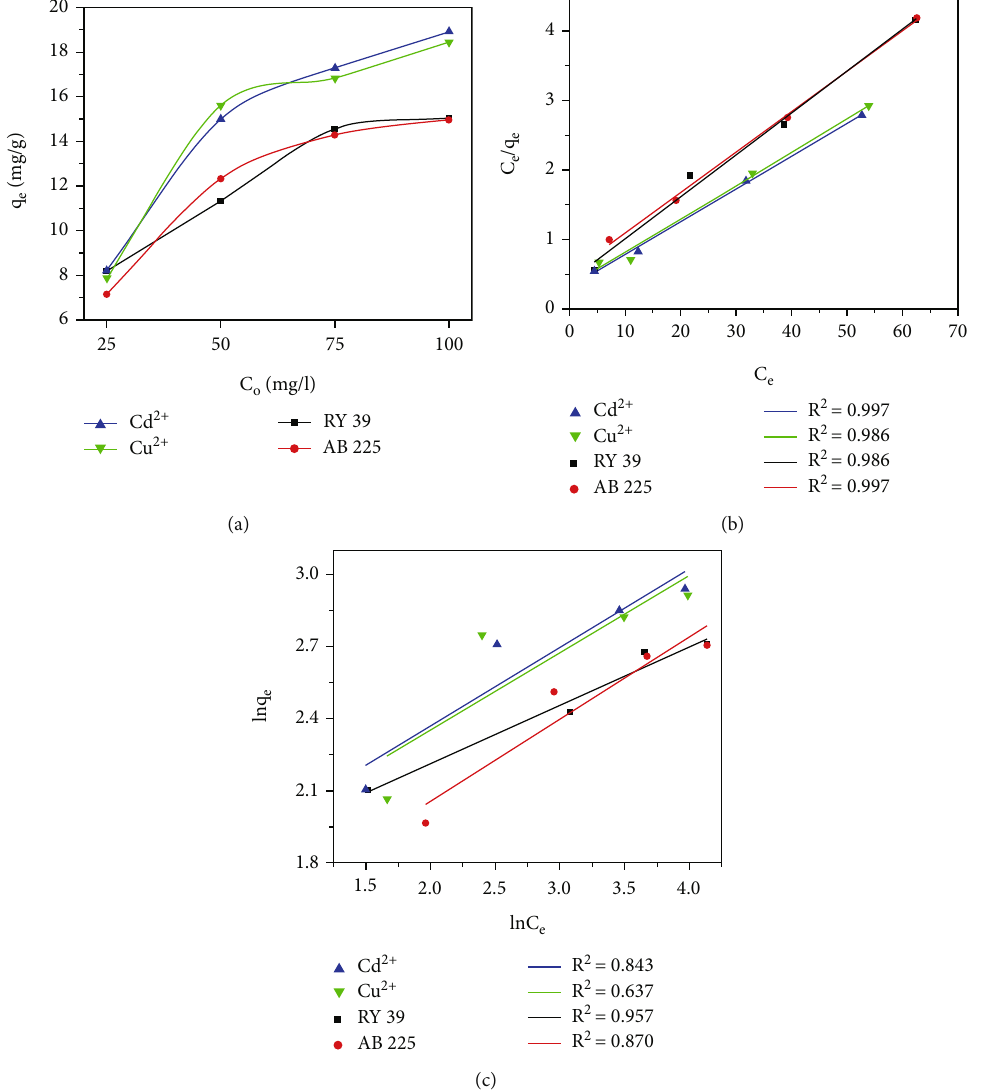
Figure 10: (a) Equilibrium pollutant adsorption onto SH-PO1 and (b) Langmuir and (c) Freundlich adsorption isotherms and the linear fi t of experimental adsorption data for di ff erent pollutants. Table 5: Isotherm models ’ equations and obtained isotherm parameters for metal ions and dyes adsorption onto SH-PO1. Adsorption